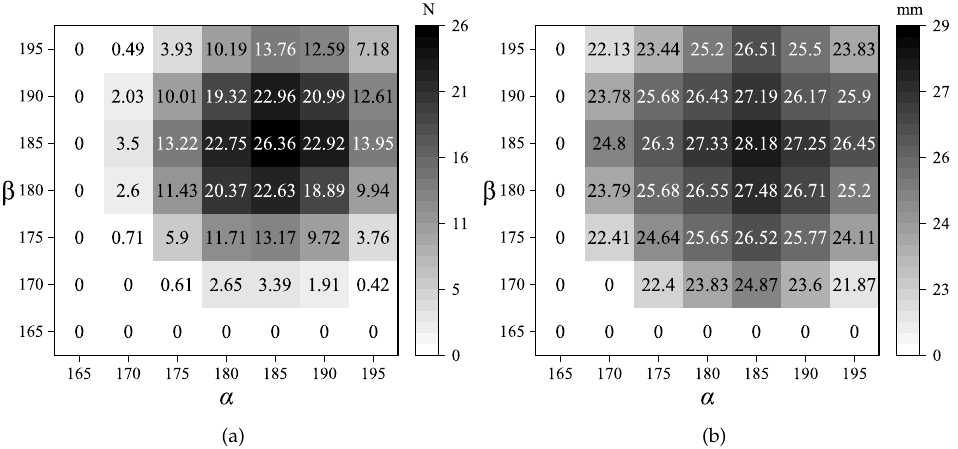
Figure 4. The switch-back forces and second stable positions when α and β are close to 180 ◦ . When the switch-back force is 0, it represents the structure is absent of bistable characteristics: ( a ) the forces at the second critical points; ( b ) the displacements at the second stable